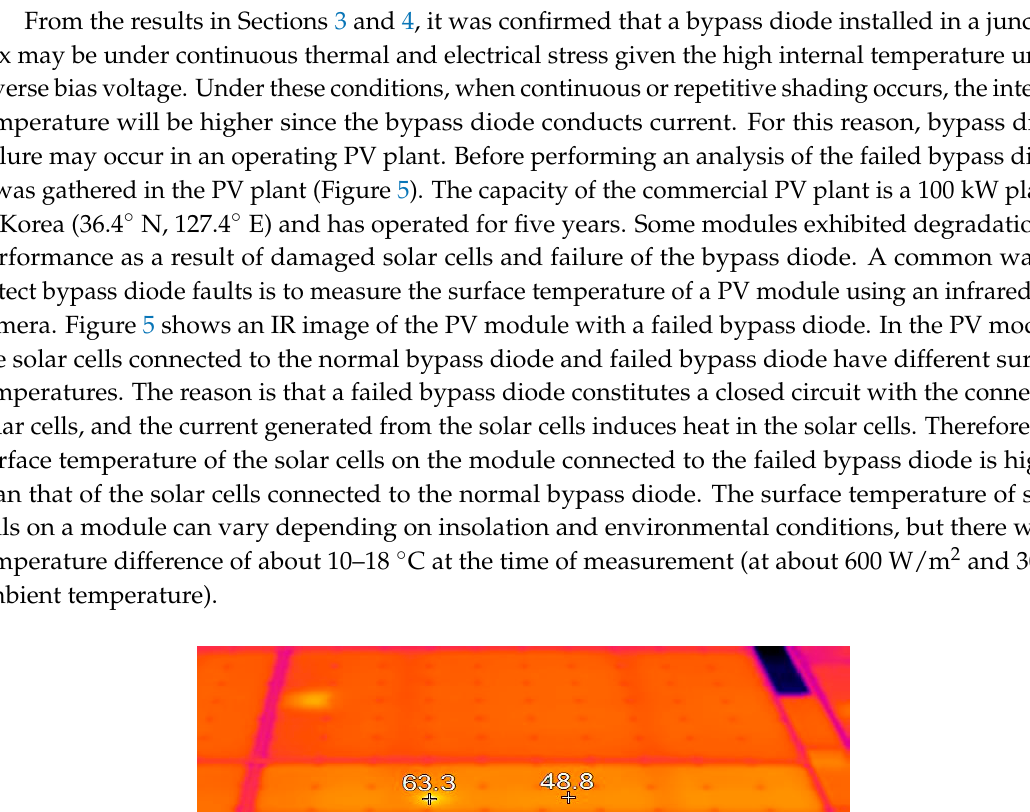
Figure 6. Measured I–V curves of the normal and failed bypass diode.